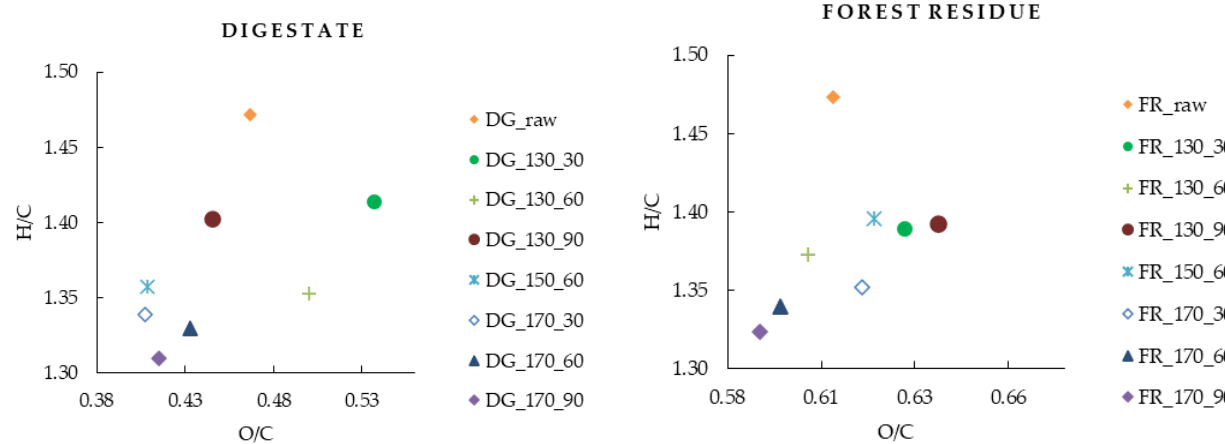
Figure 1. H/C and O/C ratios based on mean values for the digestate (DG) and forest residue (FR) of raw and hydrothermally treated solids at different temperatures (130 – 170 °C) and holding times (30 – 90 min). Single measurements can be found in Appendix A.